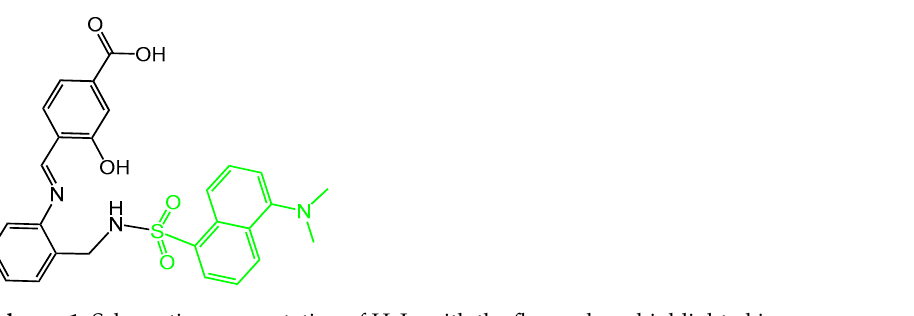
Scheme 1. Schematic representation of H 3 L, with the fluorophore highlighted in green.